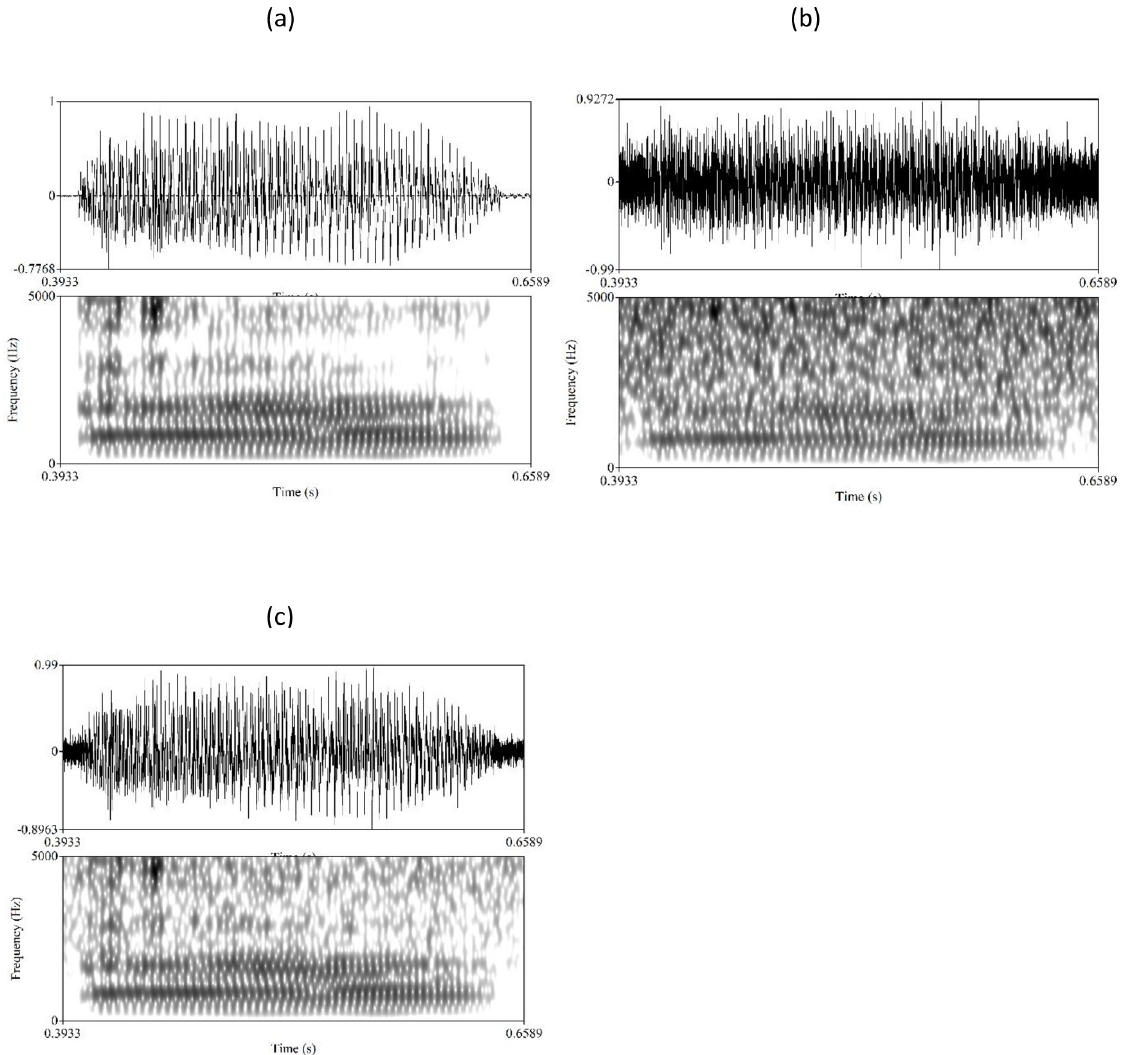
Fig 3. Waveforms and spectrograms of a speech stimulus. Original stimulus (a) and mixed with noise at SNR ratios of -6 dB (b) and +6 dB